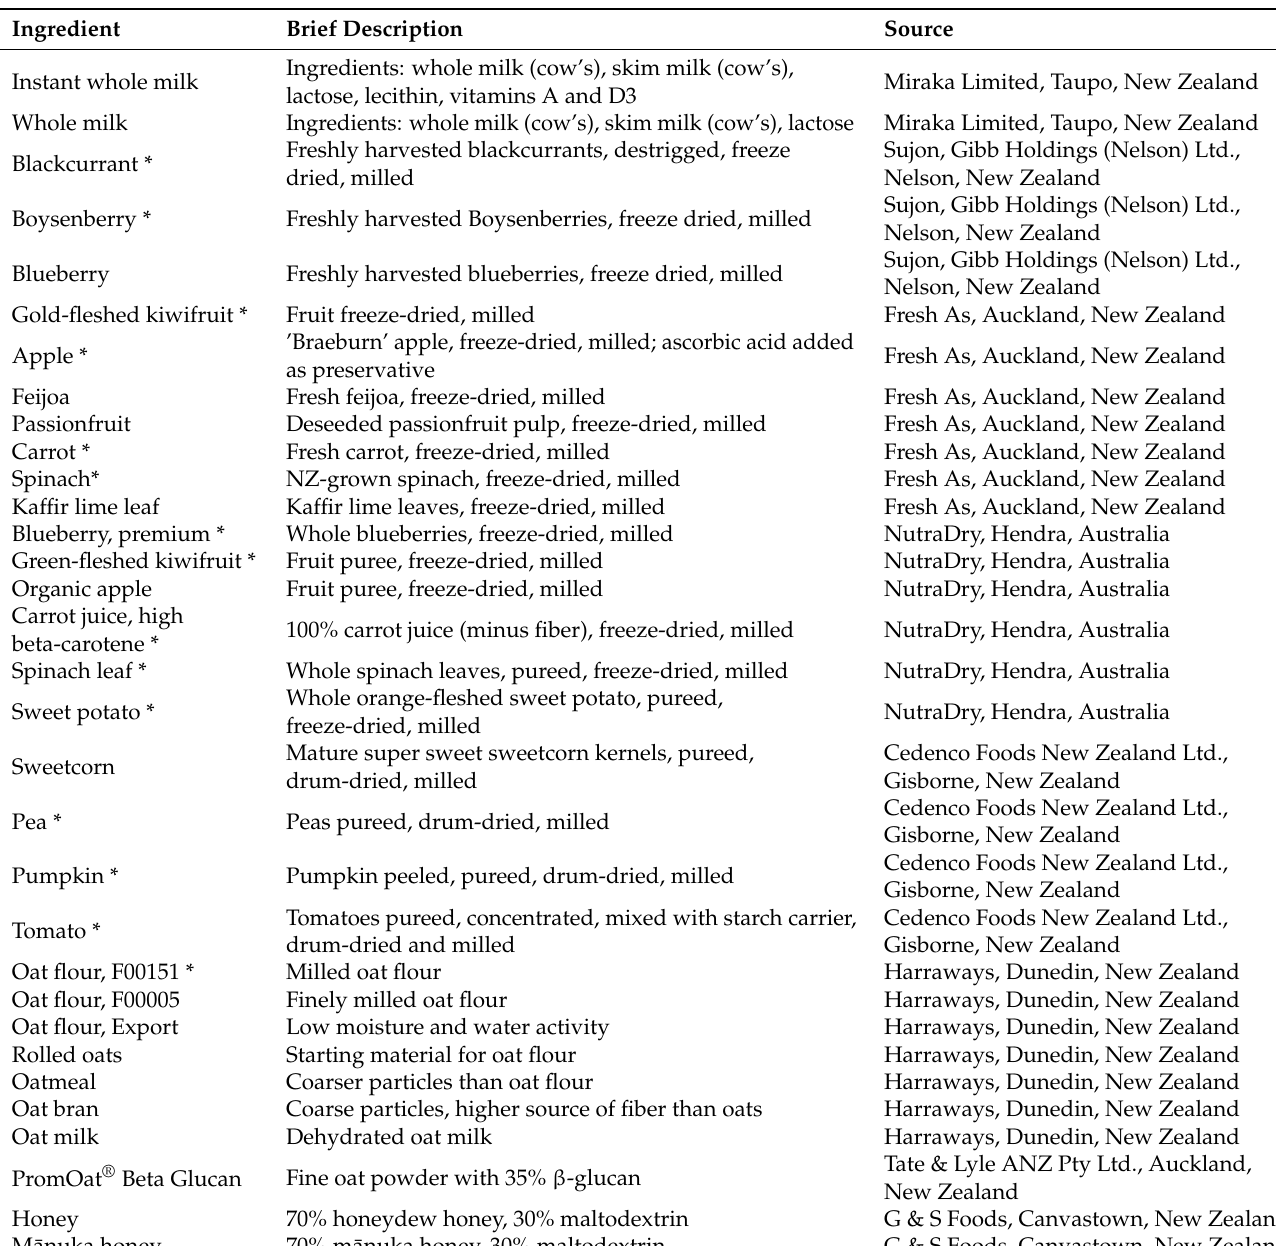
Table 1. List of ingredients subjected to in vitro gastroileal digestion and colonic fermentation. The fermenta were analyzed for organic acid metabolites at 0, 5, 10, 16, and 24 h of fermentation. The fermenta from a subset of ingredients (marked with an asterisk) were also analyzed for microbiota composition using 16S rRNA gene sequencing at 0, 5, and 10 h of